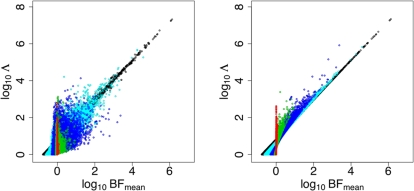
Graph showing correspondance between log10(BFmean) values and Likelihood ratio statistics Λ (left) and Λmean (right).Each point represents one SNP-phenotype combination, colored according to average confidence in imputed genotypes. Specifically, the SNPs were colored according to the value of r, defined to be the ratio of the variance of the (posterior mean) genotypes and the expected variance if the SNP were typed, calculated from the MAF assuming Hardy-Weinberg equilibrium (2f(1−f)). This scaling ensures that for typed and confidently-imputed SNPs r≈1, whereas for SNPs with low average confidence r will be close to 0. Colors indicate ranges of values of r: red r∈(0,0.001]; green r∈(0.001,0.01]; blue r∈(0.01,0.1]; cyan r∈(0.1,0.5]; black r>0.5.